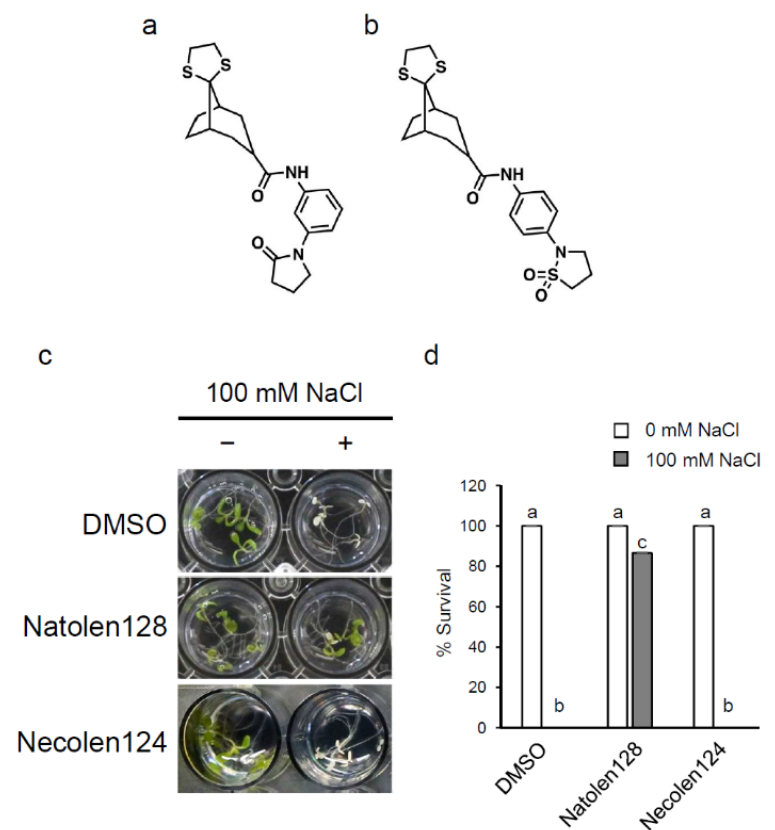
Figure 1. Natolen128 enhances high-salinity stress tolerance in Arabidopsis thaliana . ( a ) Structure of Natolen128. ( b ) Structure of Necolen124. ( c ) Morphology of seedlings treated with 2 µ M Natolen128, with or without subsequent treatment of 100 mM NaCl for 4 days. Necolen124 and DMSO were used as negative controls. The inside diameter of each well is 15.4 mm. ( d ) Survival rate under high-salinity conditions in the presence or absence of 2 µ M Natolen128. The survival rate of 15 plants was calculated 4 days after NaCl treatment. These experiments were conducted using three biological replicates. Error bars represent the mean ± standard error (SE). Statistical significance was determined by ANOVA, followed by post-hoc Tukey’s tests. Means that differed significantly ( p < 0.05) are indicated by different letters.